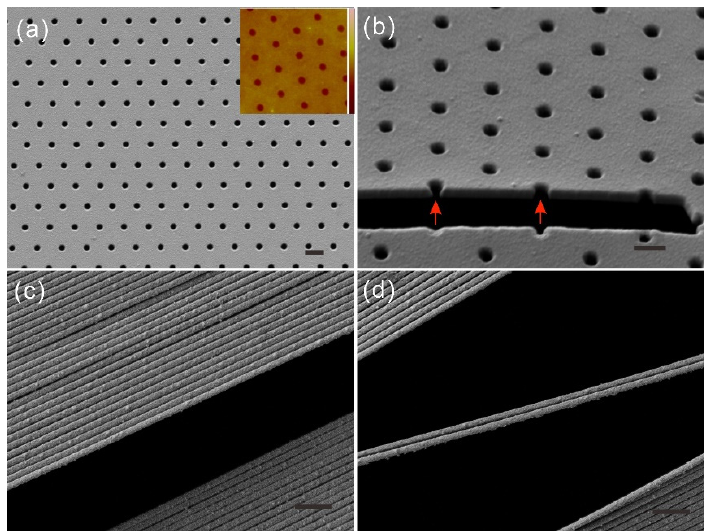
Figure 2. ( a ) Freestanding Au membrane with a hexagonal nanohole array with period of 700 nm and diameter of 200 nm. (Inset, AFM measurement; Color bar: 0 to 20 nm). ( b ) A cross-section of freestanding Au nanomembrane cut by FIB milling. Two arrows indicate the complete holes. Scale bars: 500 nm in ( a , b ). ( c ) Parallel freestanding nanowires with large gaps and sub-10 nm crevices. ( d ) Two dislocated nanowires suspending across the gap. Scale bars: 1 μ m in ( c , d ).